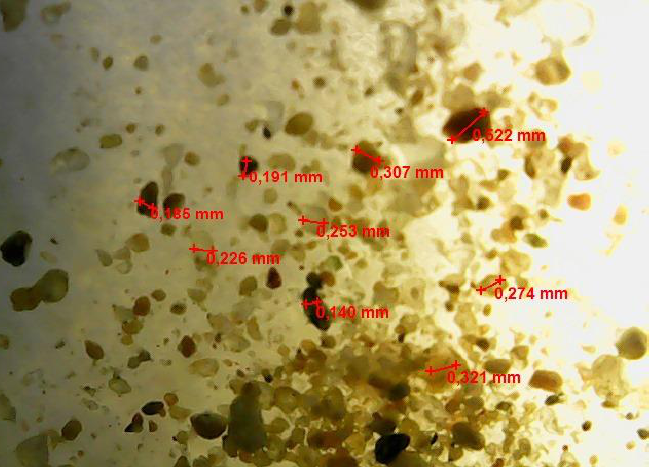
Figure 1. Original sand sample. The sand is represented by particles of both almost transparent and dark colours. Only mostly transparent sand particles were manually selected for further research. X-ray fluorescence analysis showed the following elemental composition of sand, wt%: Si 45.8; Ca 0.4; and Fe 0.1. XRD analysis revealed the presence of only a quartz (SiO 2 ) phase in the sand (Figure 2).